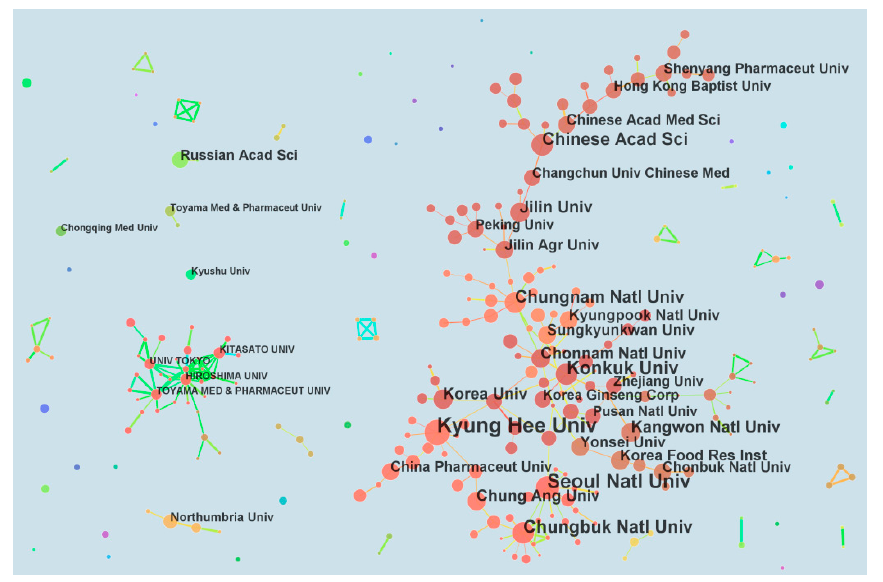
Figure 3. The collaboration patterns of global research institutions.